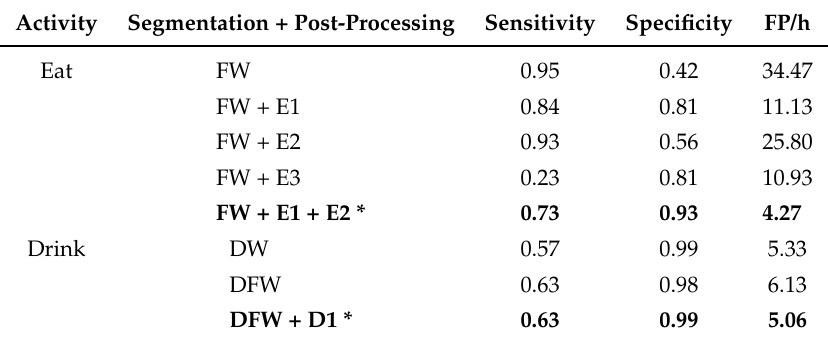
Table 6. Performance metrics of eating and drinking recognition, based on Random Forest classification, with respect to the added